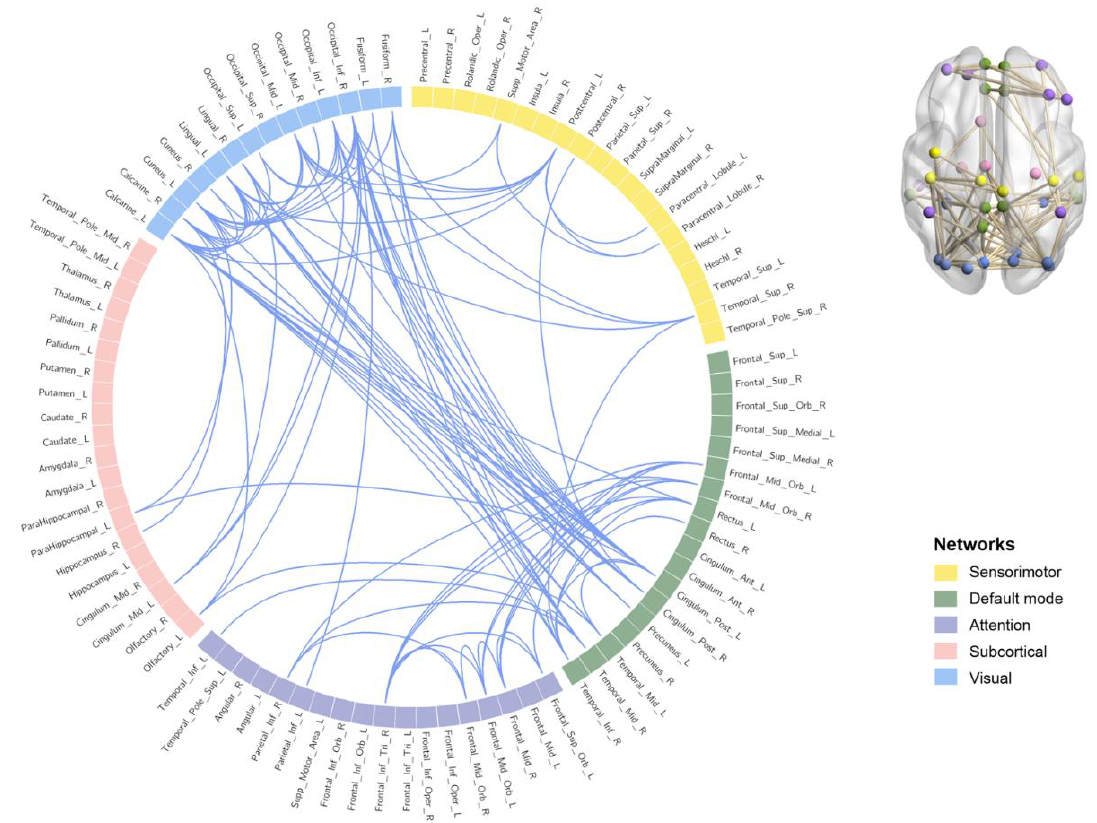
Figure 5. Whole brain functional connectivity results. The squares represent 90 brain regions. The yellow squares represent sensorimotor networks, the green squares represent default mode networks, the purple squares represent attention networks, the pink squares represent subcortical networks, and the blue squares represent visual networks. The connection is a significant functional connection.